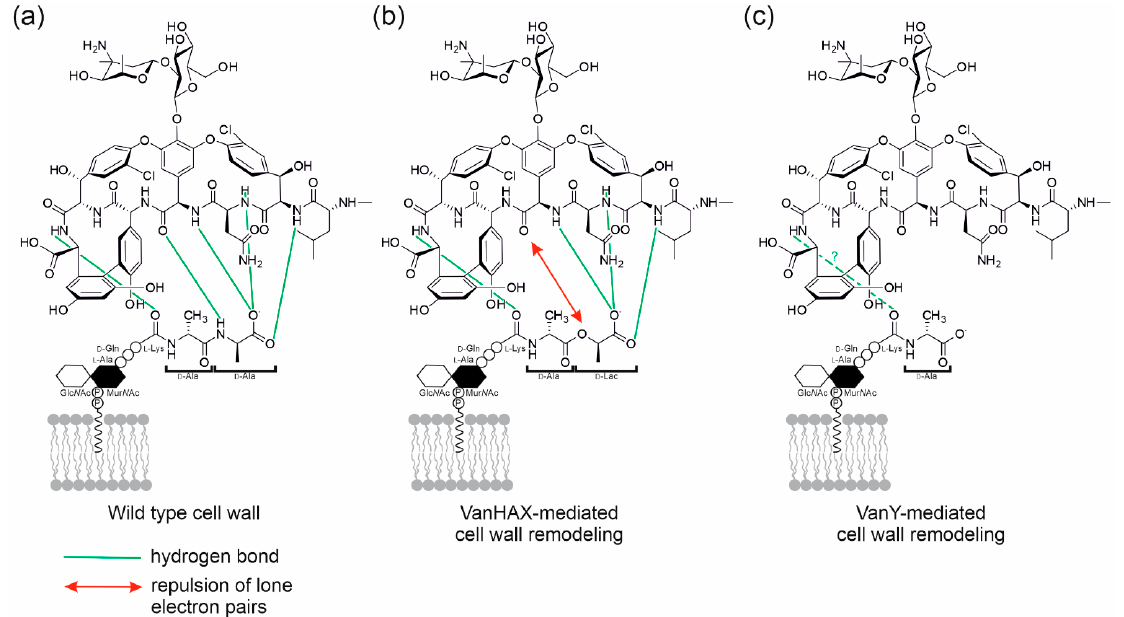
Figure 1. Schematic representation of ( a ) vancomycin (as a model GPA), interacting with the D -Ala- D -Ala terminus of the lipid II pentapeptide stem of a Gram-positive cell wall, forming five hydrogen bonds [10]; ( b ) in the cell wall remodeled by the action of VanHAX, the D -Ala- D -Lac termini of lipid II pentapeptide stem interacts with a significantly lower (1000 fold lower) affinity with vancomycin, due to the formation of only four hydrogen bonds and the repulsion of lone electron pairs between oxygen atoms [11]; ( c ) in the cell wall remodeled by the action of VanY D , D -carboxypeptidase, the lipid II pentapeptide stem is truncated by the excision of the terminal D -Ala, and vancomycin affinity for this target appears significantly reduced, although to which extent has not been investigated yet.